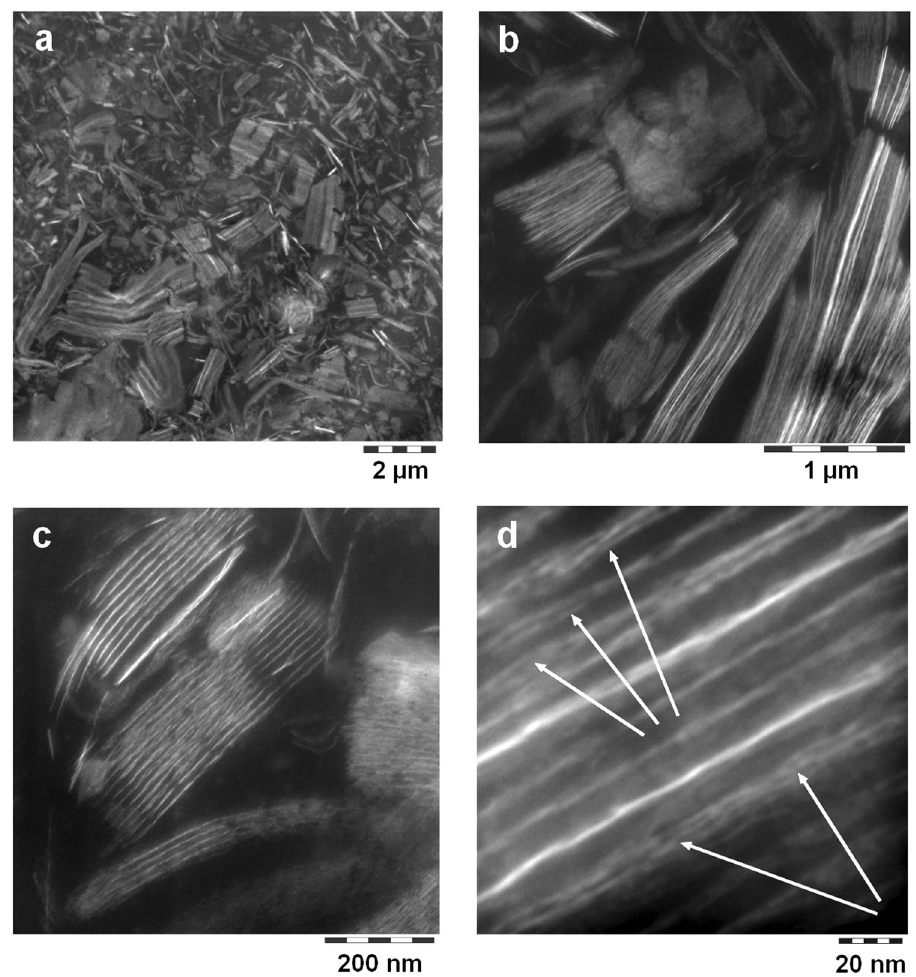
Figure 2. Cryo-TEM pictures zooming into the film of b-PES derived LDH-NC. Arrows in ( d ) indicate fagots of few layers with 2 nm spacing.